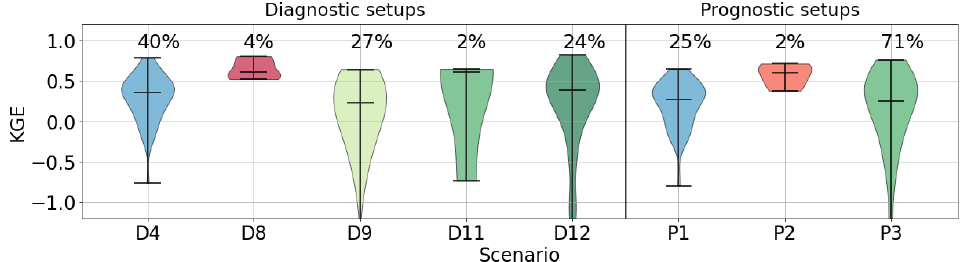
Figure 7. Event-based KGE distribution for the selected scenarios at each station.